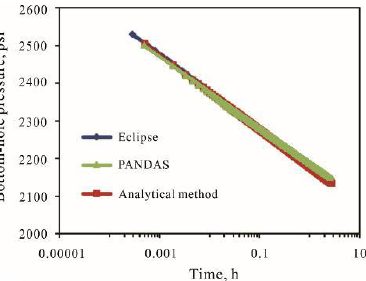
Figure 2. Comparison of semilog plots of bottom-hole pressure during the pressure drawdown test calculated by PANDAS and Eclipse.